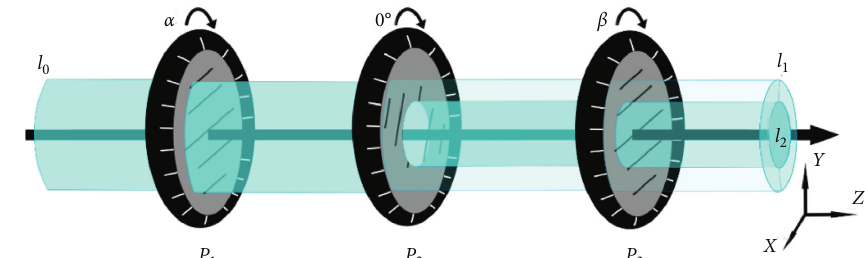
Figure 1: Schematic diagram of the three thin-film polarizers.